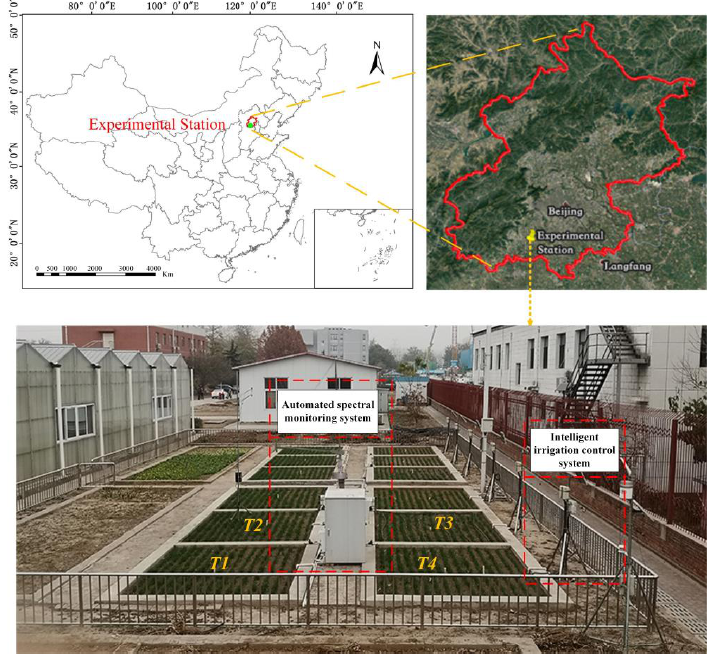
Figure 1. The location of experimental station. Table 1. Soil properties in the experimental field.